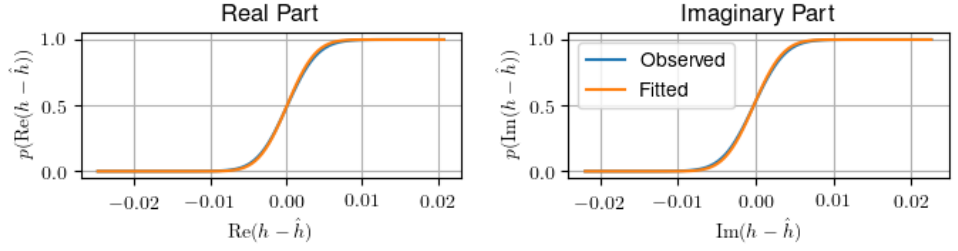
Figure 6. Empirical CDFs and Gaussian fits of the estimation error. The error distribution both in real and imaginary part is well approximated as Gaussian, validating the assumptions for the AIC.